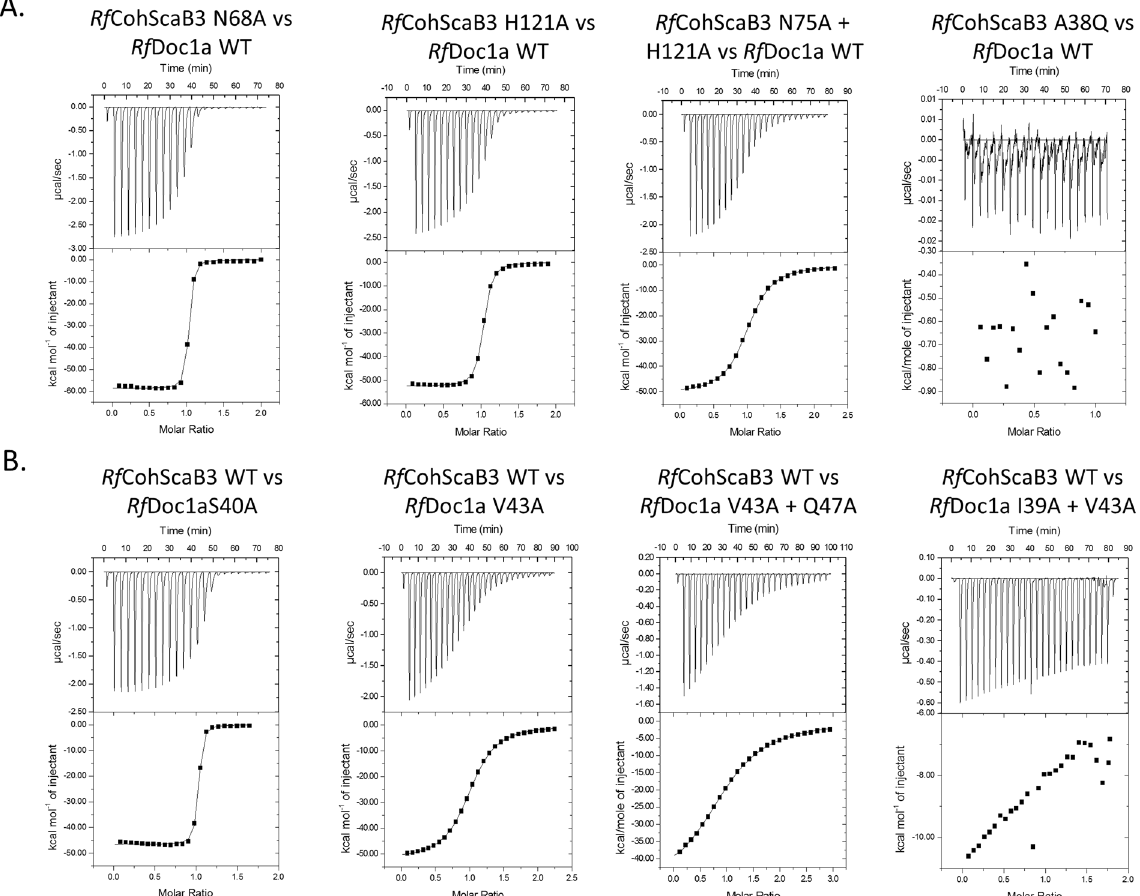
Figure 3. Determination of the contribution of key residues of Rf Doc1a and Rf CohScaB3 for the Coh-Doc interaction. ( A ) Representative binding isotherms of the interactions between the wild-type Rf Doc1a and several cohesin mutants. ( B ) Representative binding isotherms of the interactions between the wild-type Rf CohScaB3 and several dockerin mutants. The isotherms are arranged according to loss of function, from no loss to complete loss. The upper part of each panel shows the raw heats of binding, whereas the lower parts comprise the integrated heats after correction for heat of dilution. The curve represents the best fit to a single- site binding model. The corresponding thermodynamic parameters are shown in Table